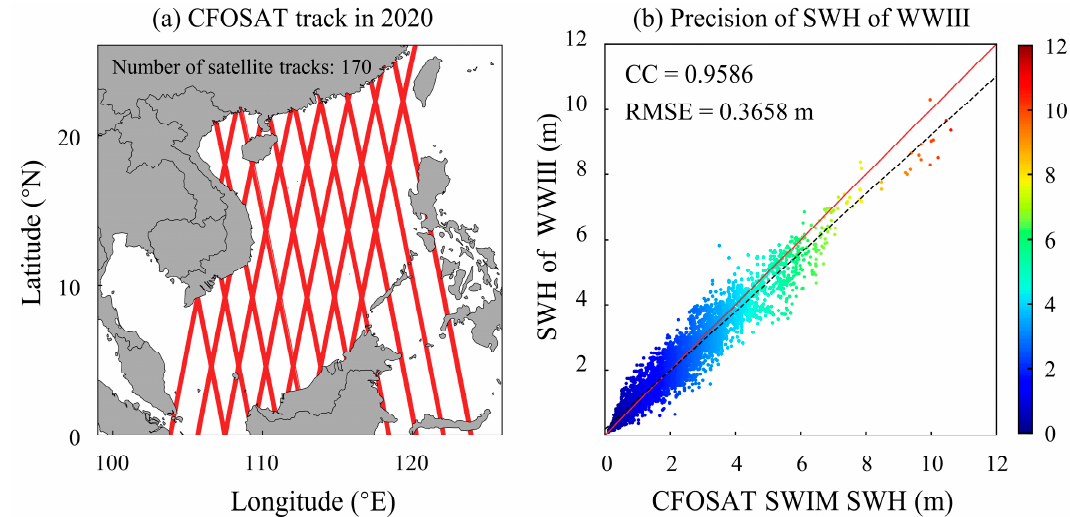
Figure 3. CFOSAT SWIM SWH was for verification of the SWH precision for the WWIII in 2020.